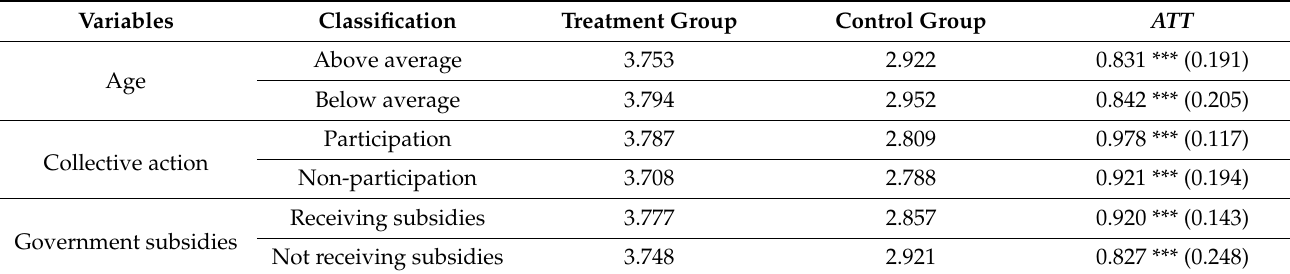
Table 4. Estimates based on endowment heterogeneity.